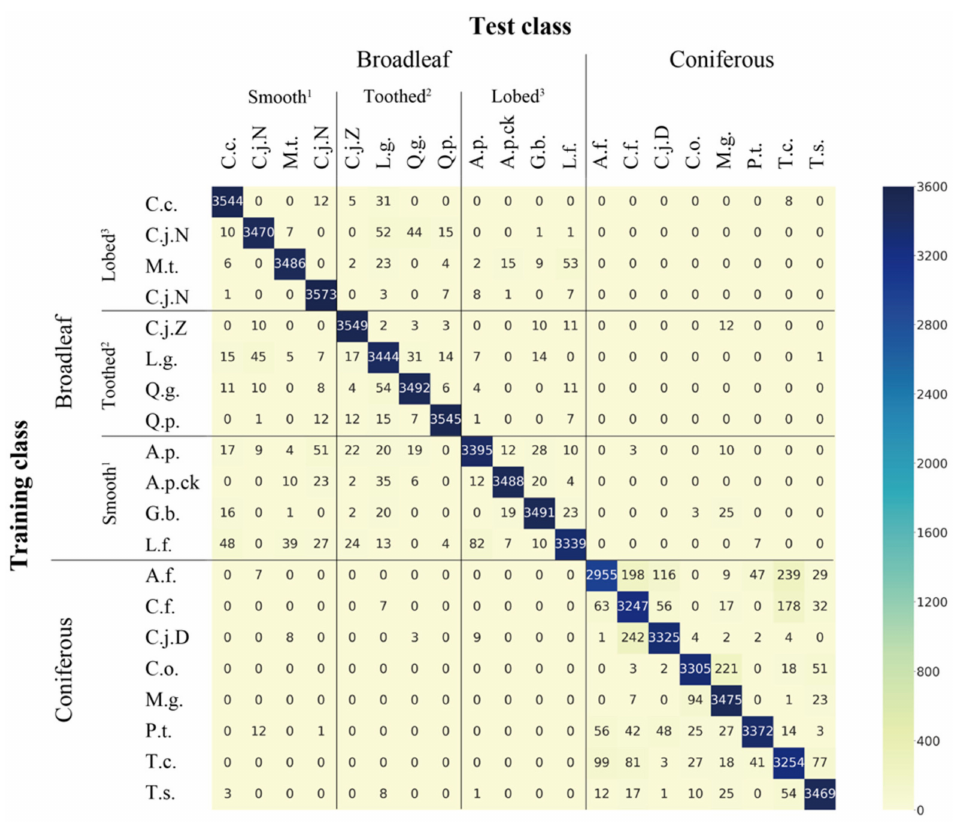
Figure 5. Misclassification patterns according to tree species in GoogLeNet after 200 epochs with data augmentation. 1 Simple leaves with smooth margins, 2 Simple leaves with toothed margins, 3 Lobed